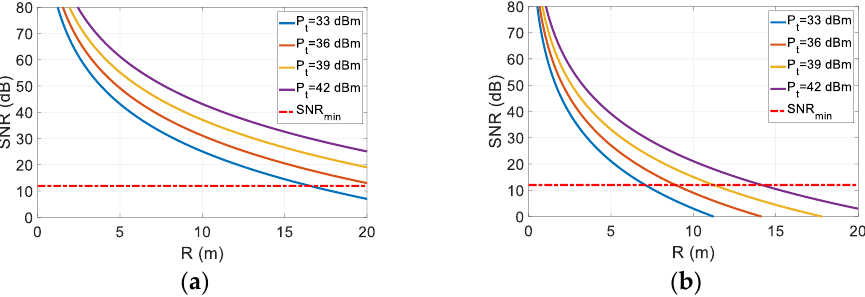
Figure 14. Estimation of the maximum detectable range for: ( a ) the laptop and ( b ) radio 1 based on the presented FMCW nonlinear radar parameters.